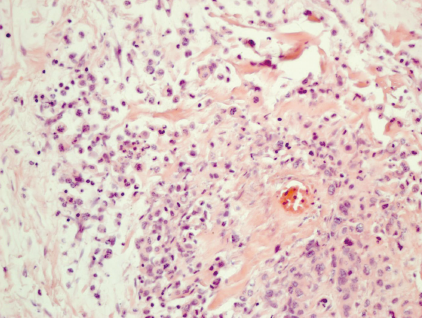
Figure 3: Histological image of ductal adenocarcinoma (hematoxylin-eosin staining, magni fi cation